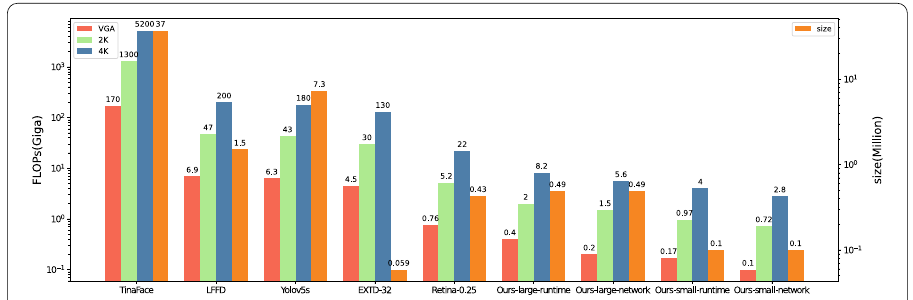
Fig. 7 The comparison of runtime complexity and the network complexity between detectors. Except for the proposed model, the other detectors have the same complexity for runtime and network because of no image